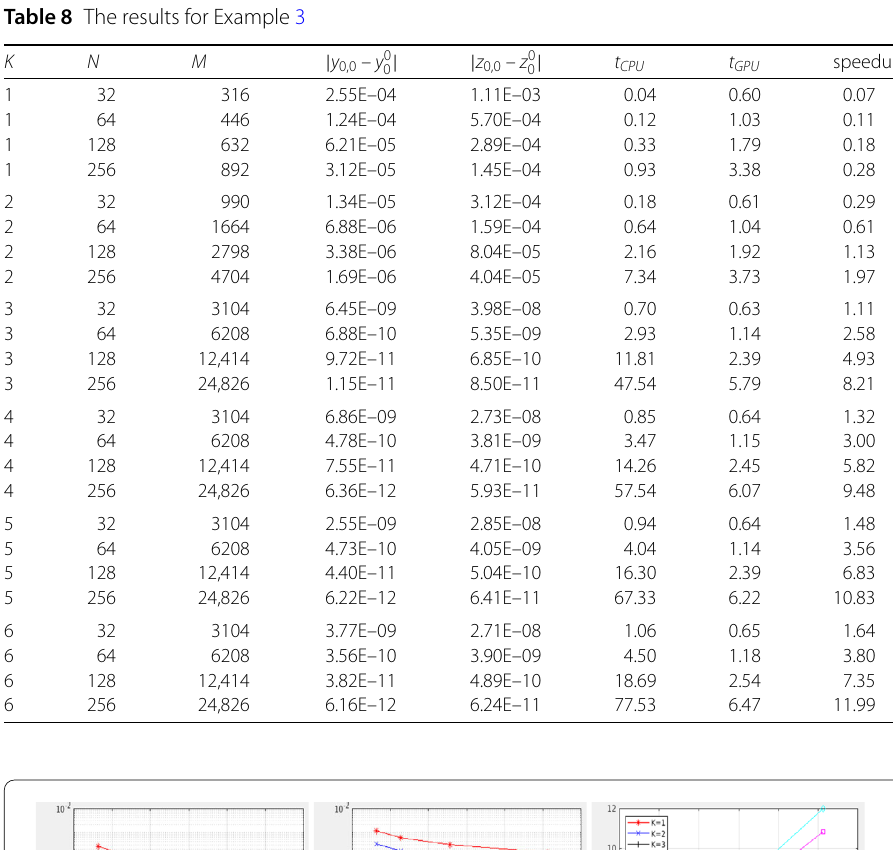
Table 8 The results for Example 3